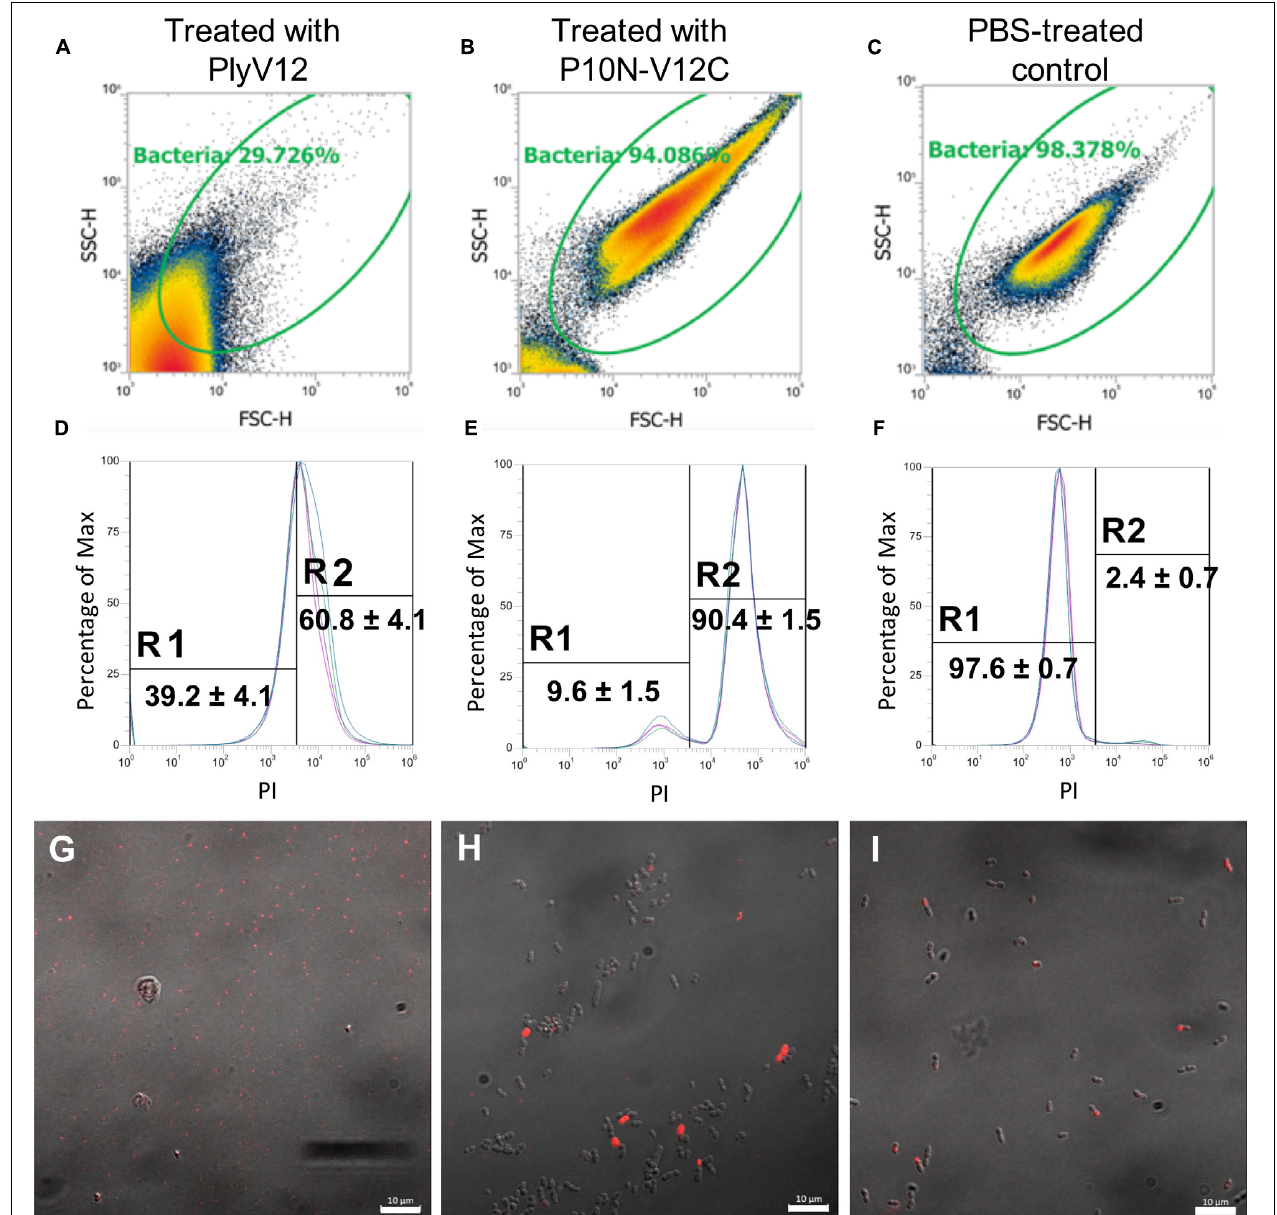
FIGURE 5 | The effect of lysin treatment on E. faecium . FSC-SSC dot plots of E. faecium strain A3 cells upon treated with PlyV12 (A) , P10N-V12C (B) , and PBS treatment (C) . (D–F) The corresponding histogram displaying percentage of gated cells with PI uptake. PI-negative and PI-positive cells are labeled with R1 and R2, respectively. Confocal microscopy images of the E. faecium cells with treatment of PlyV12 (G) , P10N-V12C (H) and PBS as control (I) . Cells with PI uptake were detected as red fluorescence signals. White bars indicate 10 µ